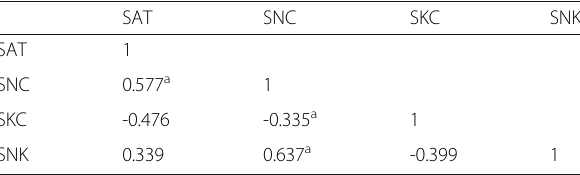
Table 1 Correlation coefficients between alkalinity tolerance- related traits in 295 japonica rice varieties